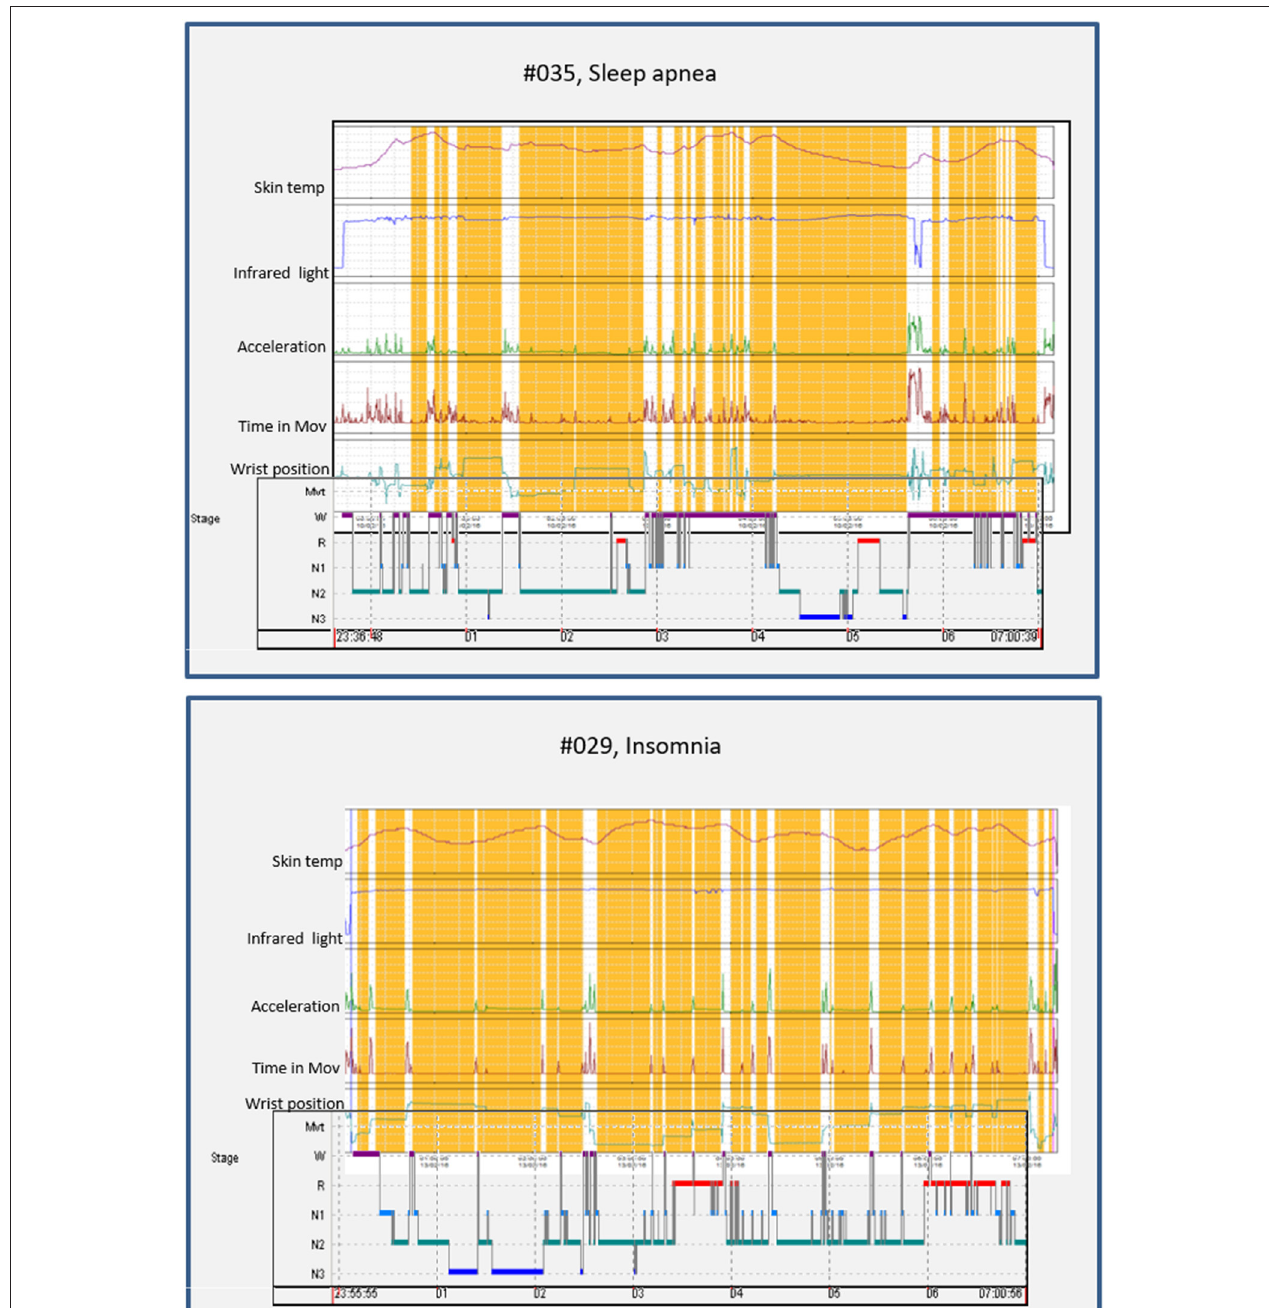
FIGURE 3 | Representative examples of two sleep pathologies (apnea and insomnia), for which a comparison between the hypnogram determined by PSG and the sleep pattern obtained by ACM recording is shown. The sleep detected by the ACM device is shown in orange, while the awakenings appear in white. The estimation of sleep and wake episodes were determined automatically based on the integration of sleep temperature, light exposure (visible and infrared), time in movement, and hand position. The corresponding hypnogram has been superimposed on the bottom of each panel to facilitate comparison.